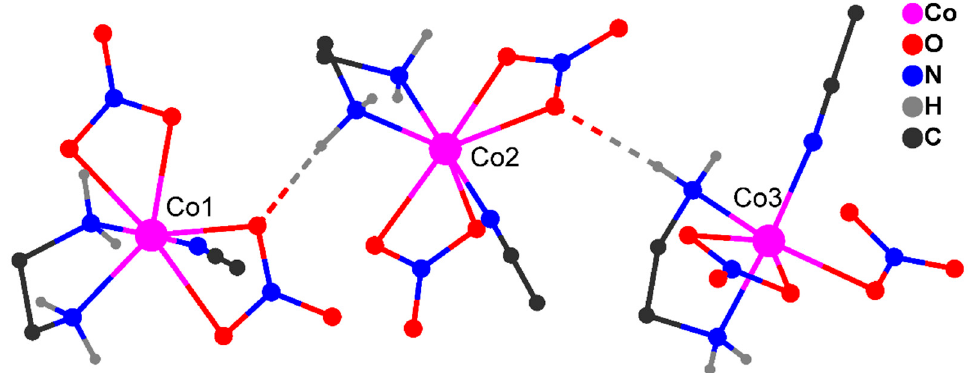
Figure 4. Molecular packing fragment of 1 (H atoms at carbon atoms are not shown; H-bonds are indicated by dashed lines).